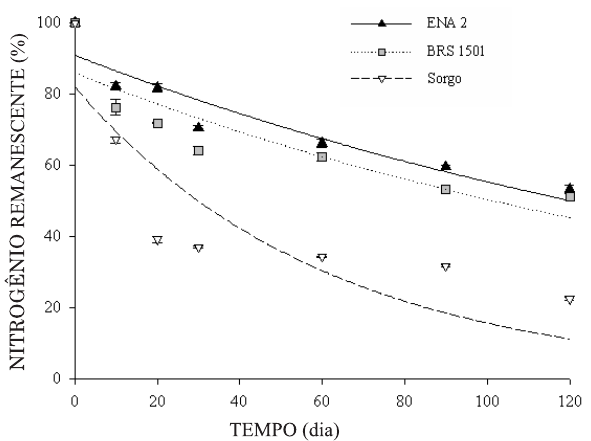
Figura 2. Teores de nitrogênio na matéria seca remanescente das plantas de cobertura em avaliações realizadas ao longo do tempo em bolsas de decomposição na superfície do solo (A equação e a significância dos ajustes estão apresentadas no Quadro 2).